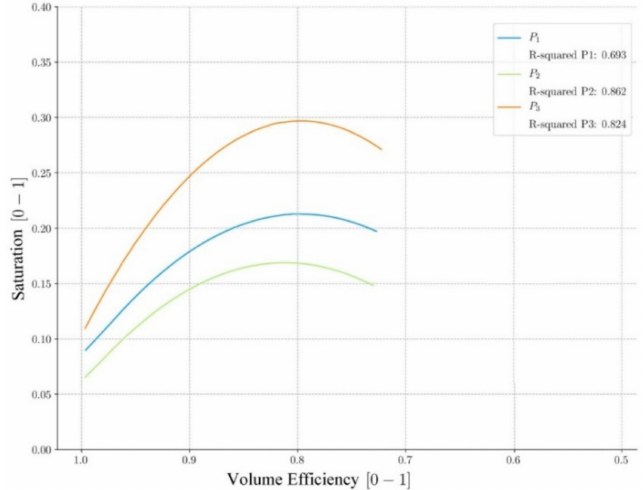
Figure 9. The relation between water saturation and volume e ffi